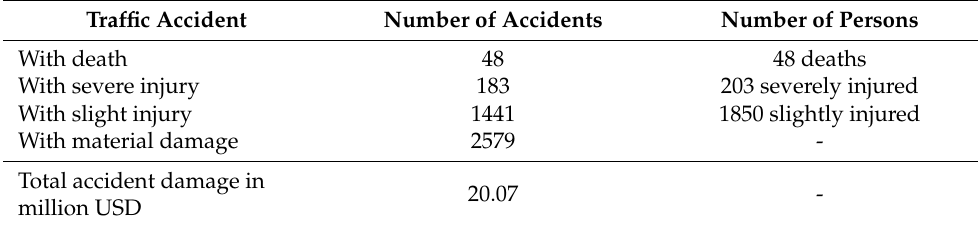
Table 12. Traffic accident damage in million USD, 2017. Traffic Accident Number of Accidents Number of Persons